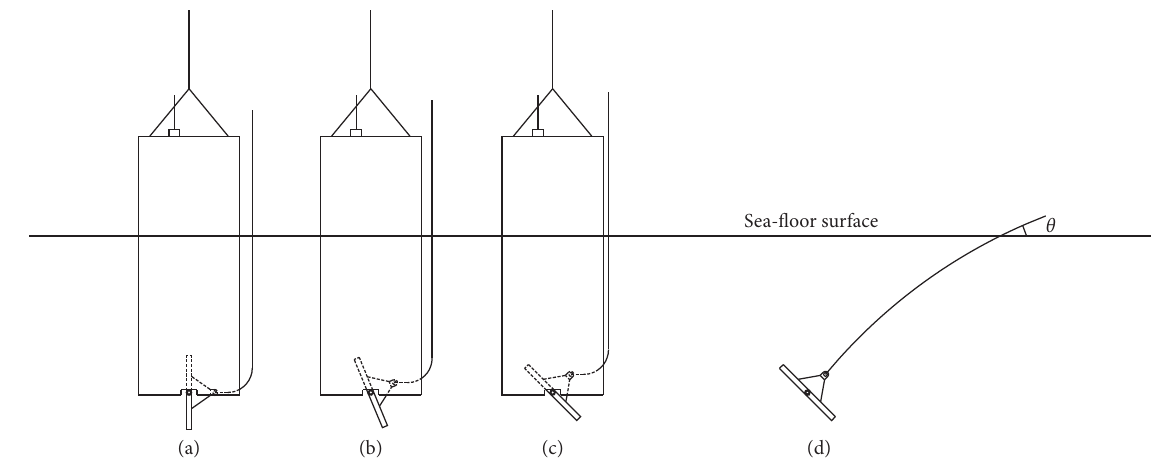
Figure 14: Improved installation process of the plate